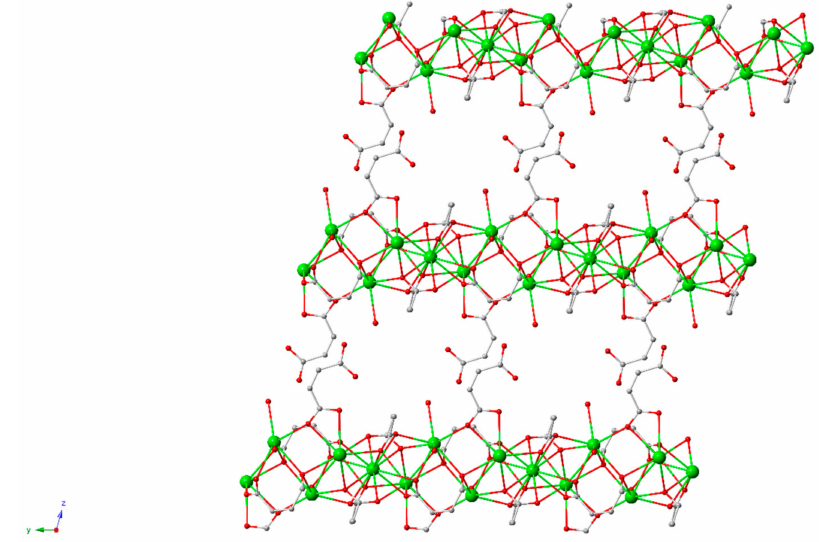
Figure 15. Structure of BM, a barium-maleate 2D material [132].